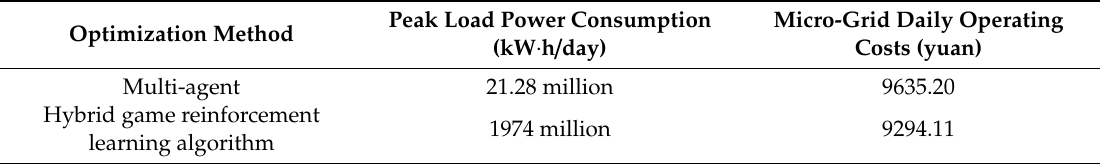
Table 6. Optimization results under the hybrid game reinforcement learning algorithm.